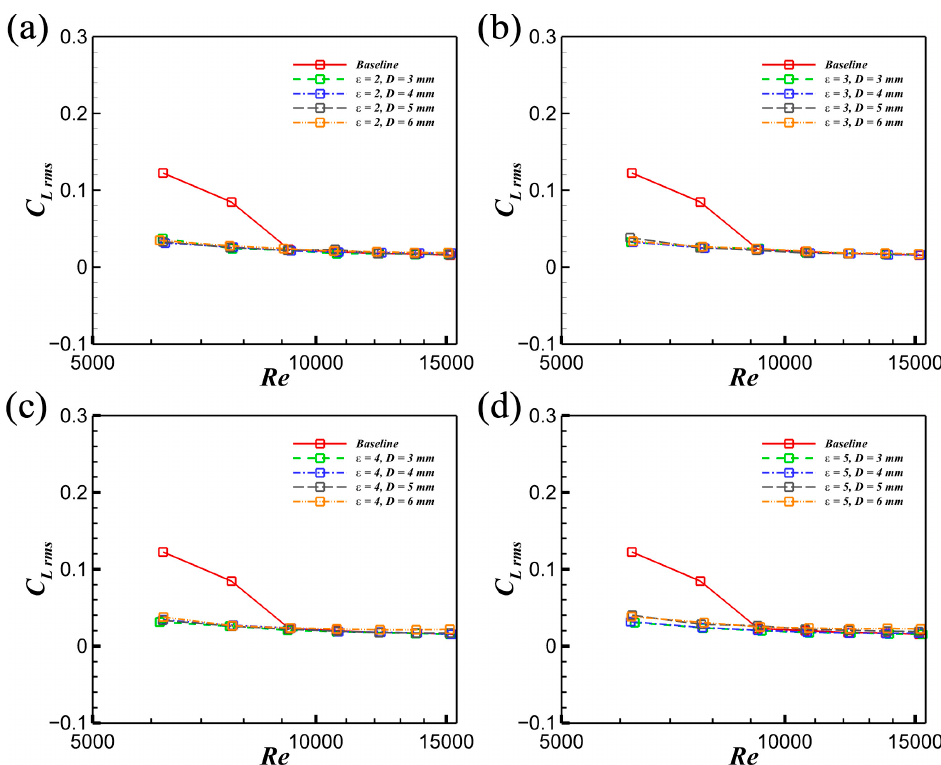
Figure 18. ( a – d ) The relationship between the fluctuating lift force coefficient and the Reynolds number at different spacing ratios and cylinder diameters.